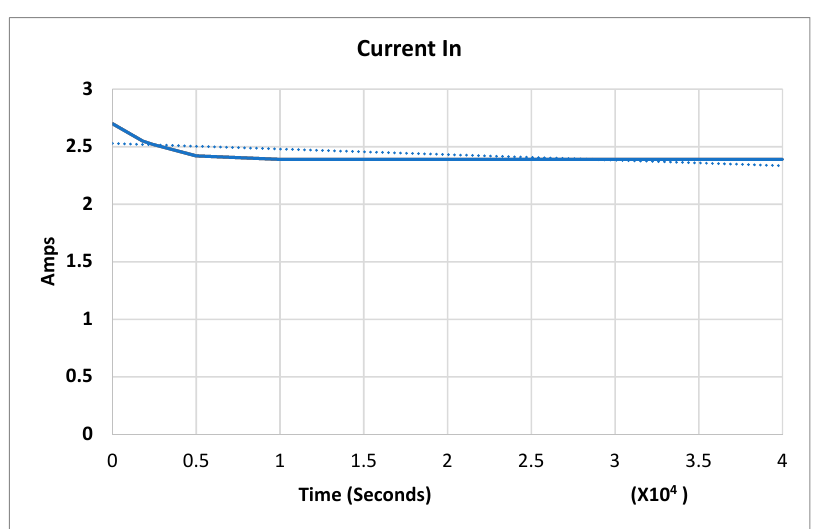
Figure 19. Charging/Battery Current.